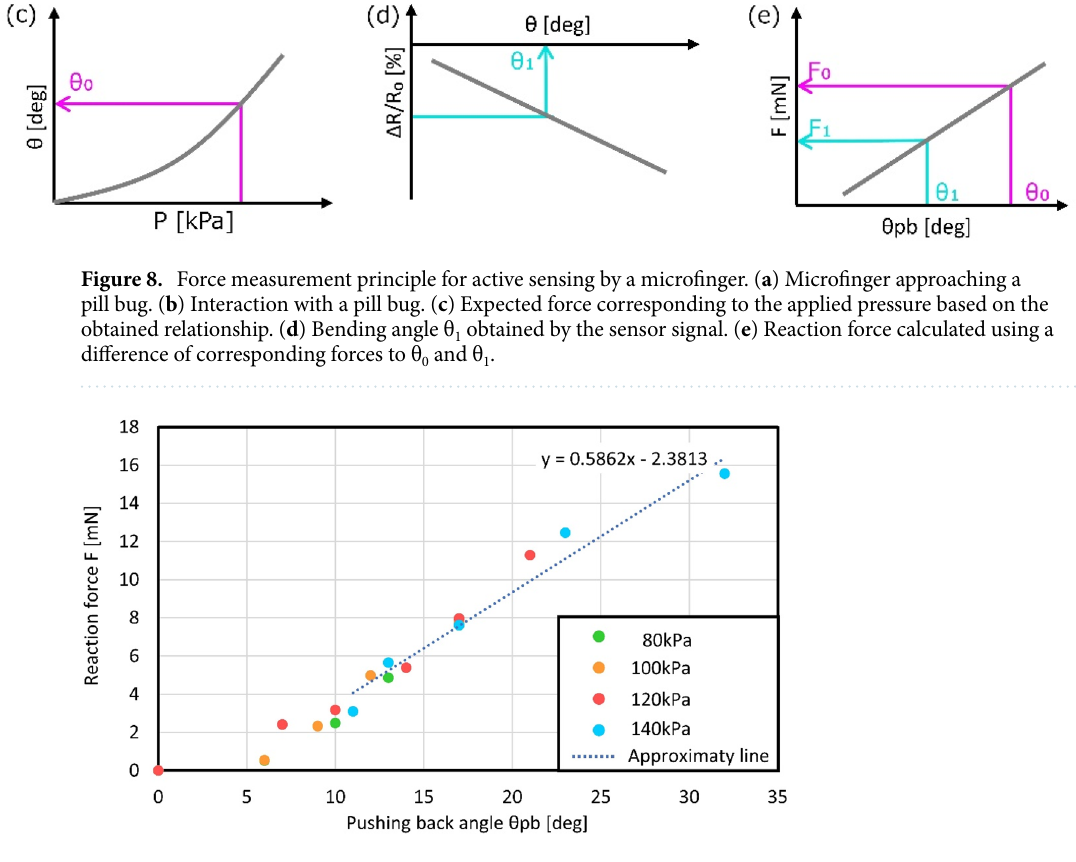
Figure 9. Relationship between pushing back angle θ pb (θ pb = θ 0 –θ 1 ) and reaction force F, which is obtained through the calculation steps from ( c ) to ( e